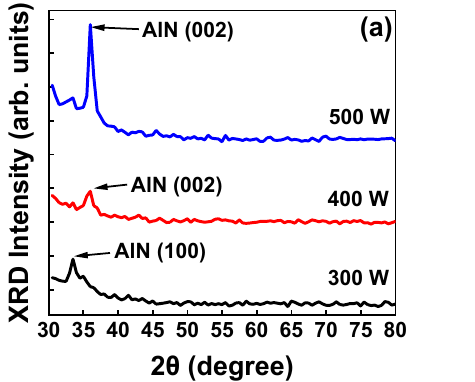
Figure 1. ( a ) XRD pattern of AlN (002) thin films deposited using sputtering powers of 300, 400, and 500 W. ( b ) XRD pattern of AlN (002) thin films deposited with nitrogen flow ratios of 50%, 75%, and 100% and a sputtering power of 500 W.